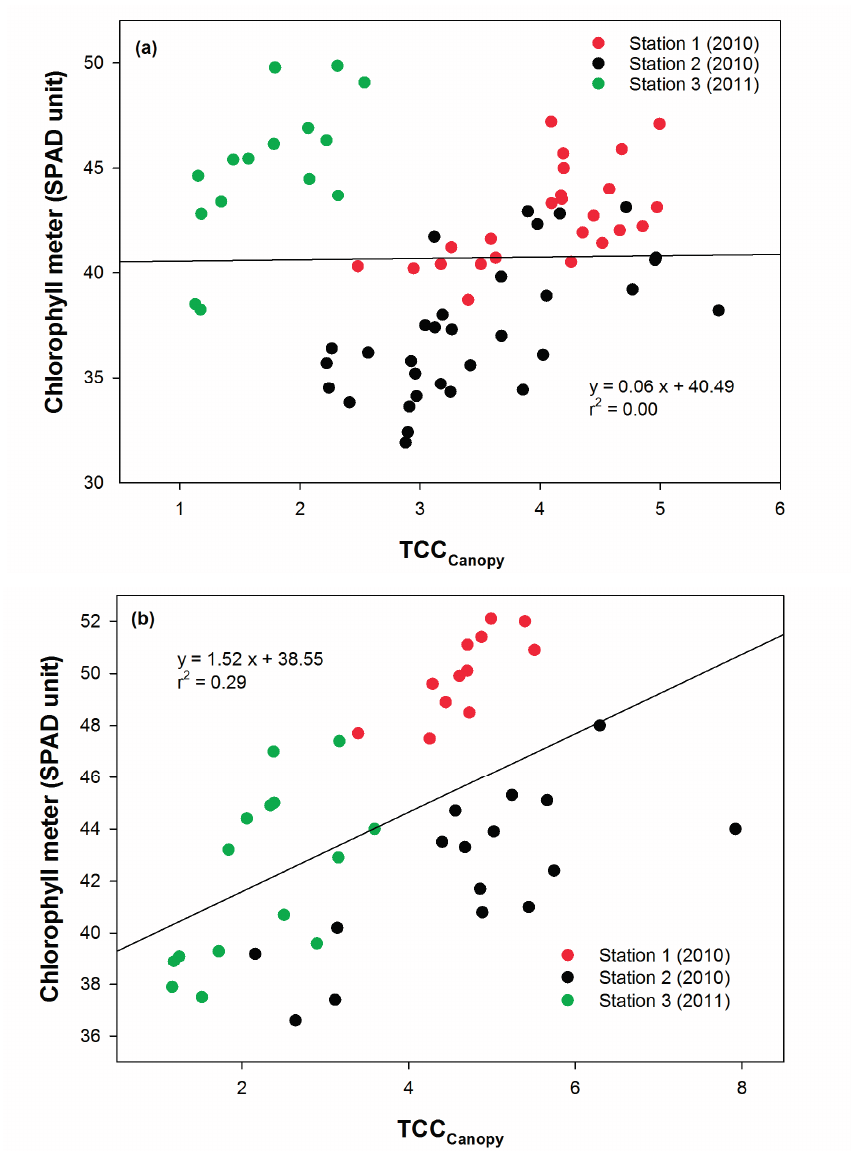
Figure 6. Linear regression between TCC Canopy and chlorophyll meter readings at ( a ) mid to late squaring, and ( b ) early